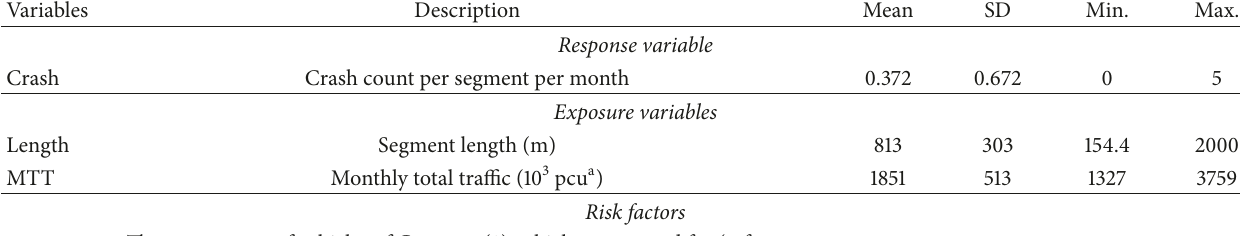
Table 2: Descriptive statistics of variables in the model.